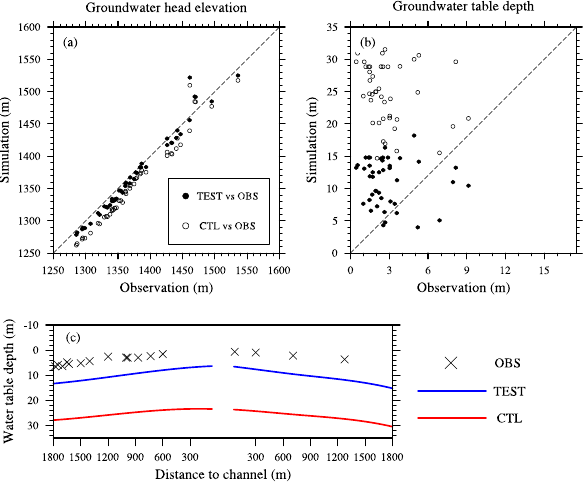
table depth predicted by TEST and CTL simulations against ob- served climatology water head data from 46 observation wells and (c) spatial distribution of the groundwater table depth from obser- vation, TEST, and CTL over the Gaotai